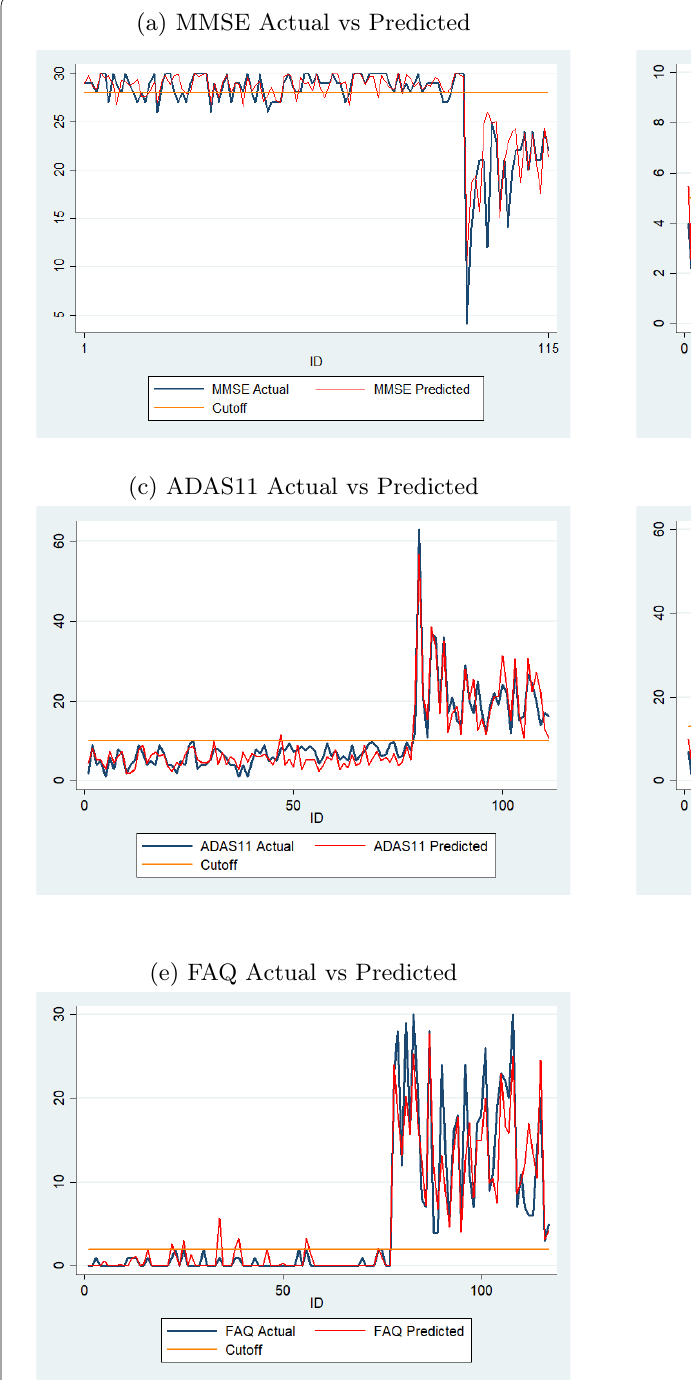
Fig. 8 Comparison of actual and predicted values by sequence prediction models at month 48 for validation data (with normal